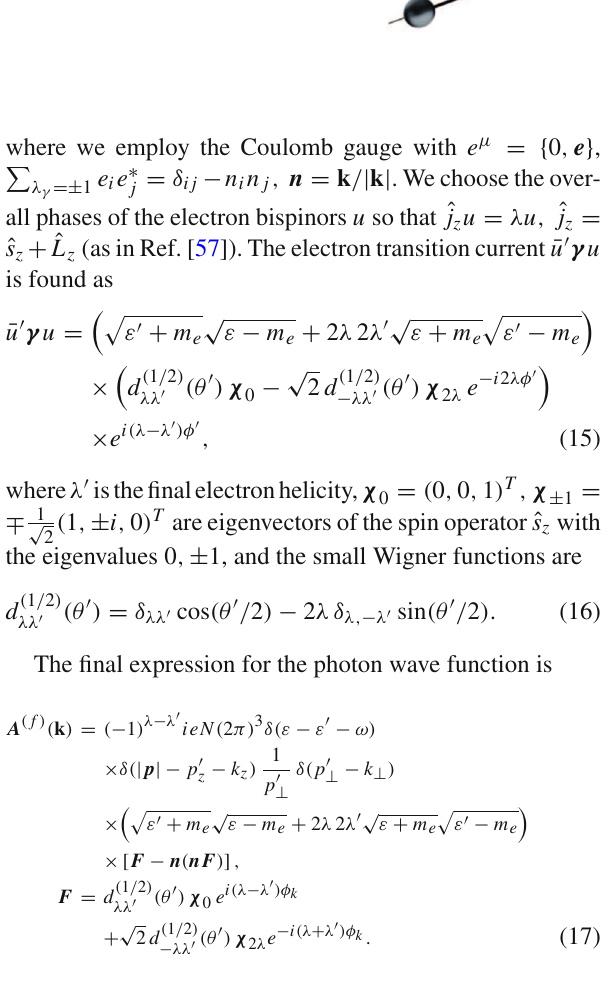
Fig. 1 An azimuthal “which-way” experiment with Cherenkov radiation: during a projective measurement of the electron momentum p (cid:6) we learn the photon angle φ k , hence, the photon is a plane wave with vanishing OAM. However if the electron angle φ (cid:6) is not precisely measured – say, when the scattering angle is very small, θ (cid:6) (cid:13) 1 – the angle φ k stays undefined, and the photon evolved state becomes